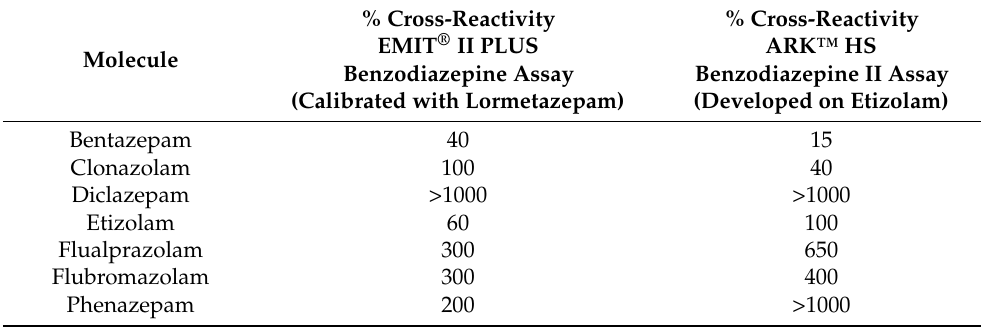
Table 3. Cross reactivity of designer benzodiazepines measured by the two immunoassays. % Cross-Reactivity % Cross-Reactivity ARK™ HS EMIT ® II PLUS Molecule Benzodiazepine II Assay Benzodiazepine Assay (Developed on Etizolam) (Calibrated with Lormetazepam) Bentazepam 40 15 Clonazolam 100 40 Diclazepam >1000 >1000 Etizolam 60 100 Flualprazolam 300 650 Flubromazolam 300 400 Phenazepam 200